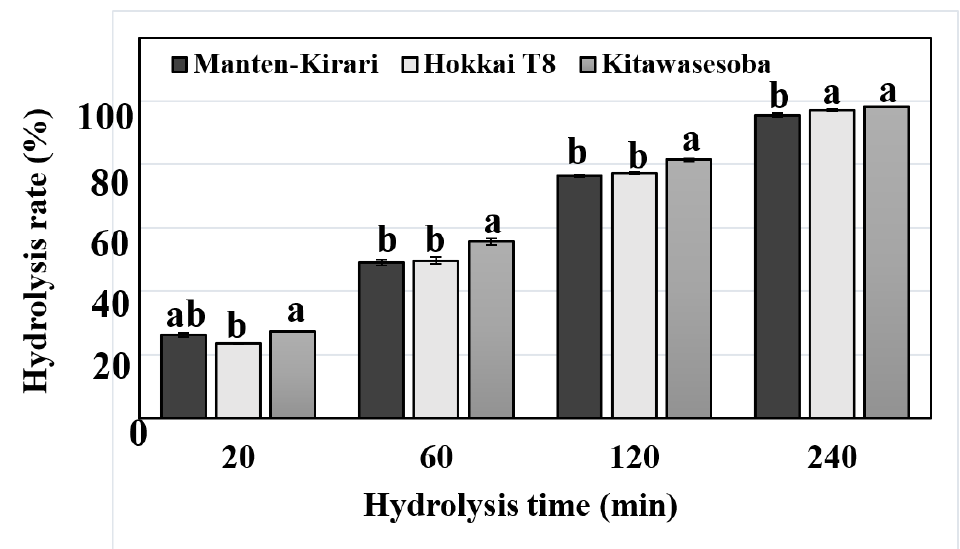
Figure 2. Hydrolysis rate of buckwheat starches by amylases. Values are means (n = 3). Error bars indicate SD. For each hydrolysis time, values with similar letters do not differ significantly ( p > 0.05).